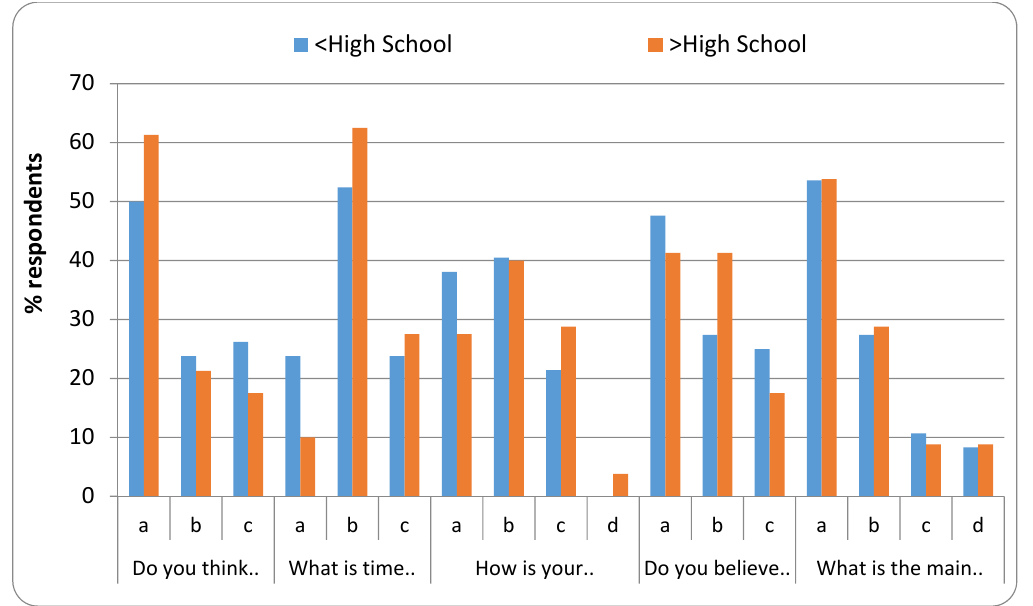
Figure 5. Distribution of responses related to practice according to educational status.